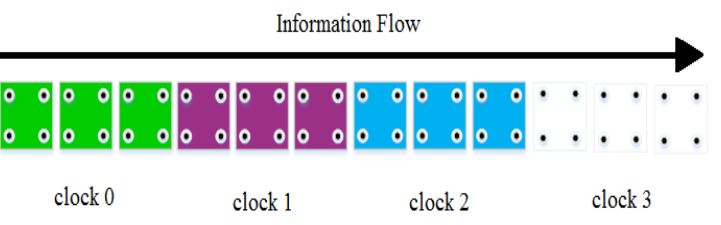
Figure 2. Clock zones for QCA